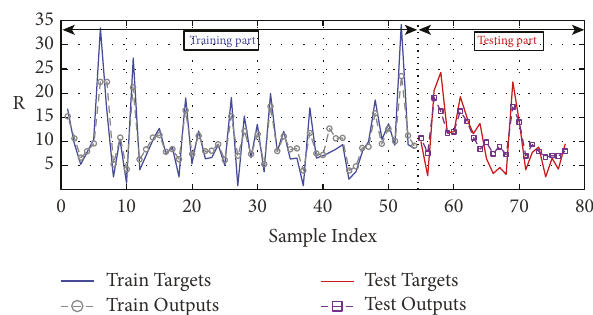
Figure 7: Comparison of the performance of EDT model with the actual values of R in function of: (a) The training dataset; and (b) The testing dataset.